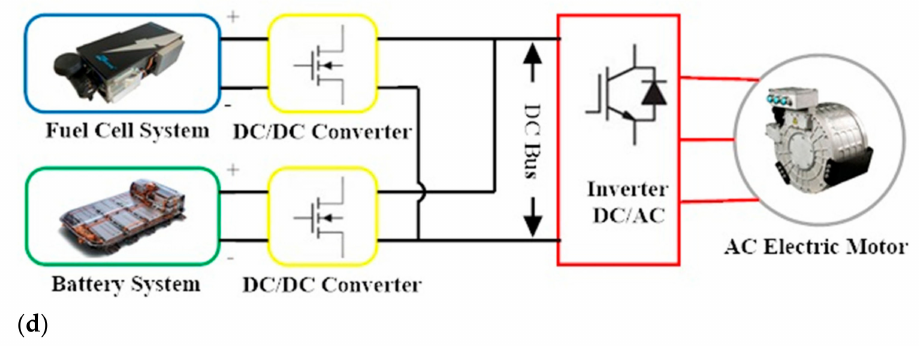
Figure 1. Topology of Fuel Cell Electric Vehicles (FCEVs): fuel cell + battery. ( a ) Topology T1; ( b ) Topology T2; ( c ) Topology T3; ( d ) Topology